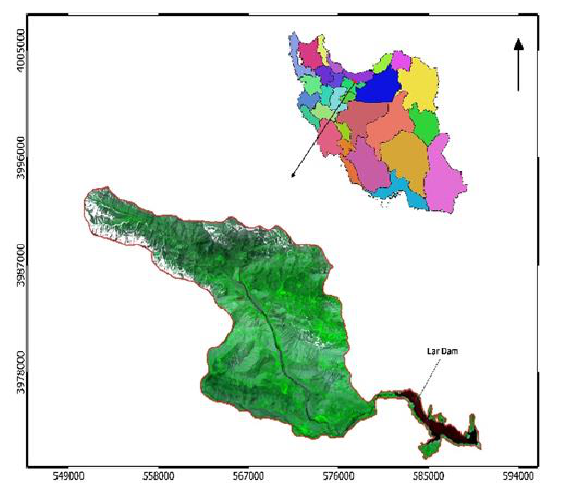
Figure 1. Location of study area in